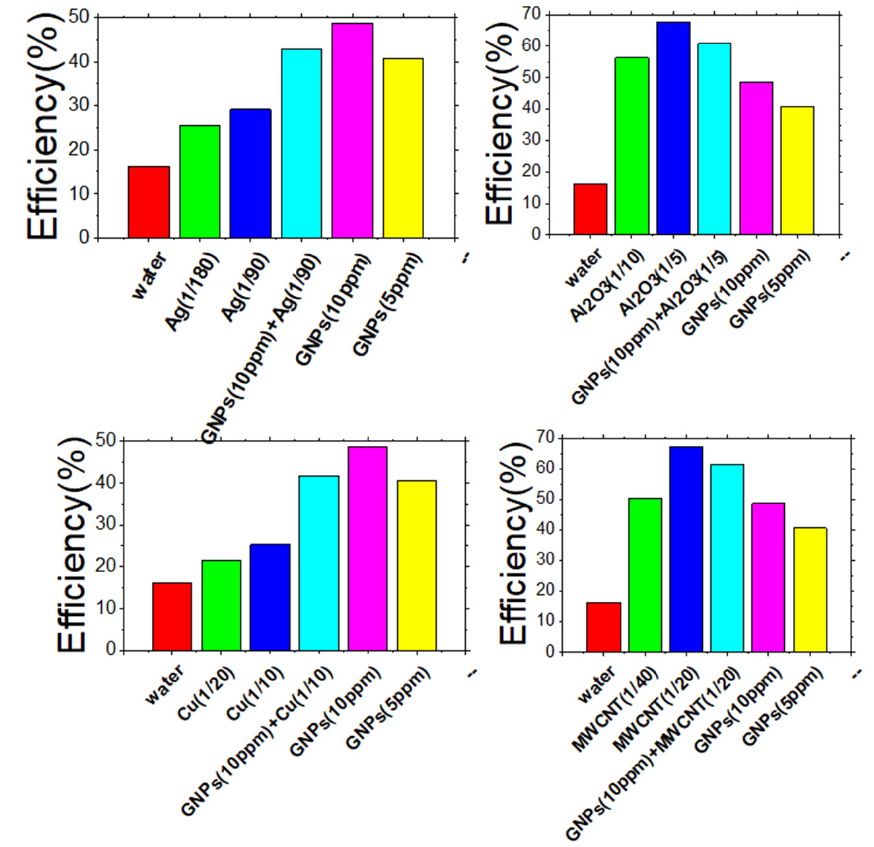
Figure 14. Absorption efficiency of experimental sample mixed with gold.